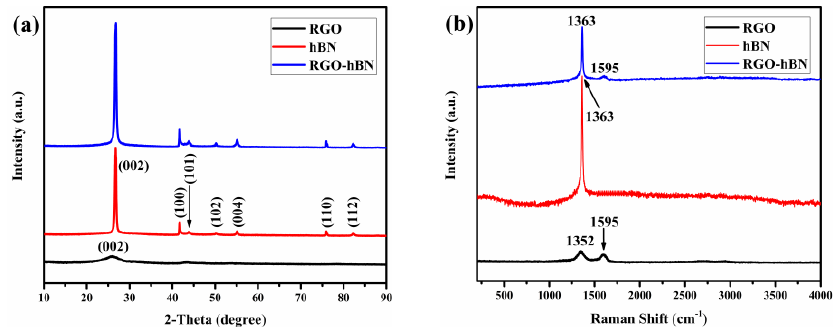
Figure 3. ( a ) XRD patterns and ( b ) Raman spectra of RGO, hBN and